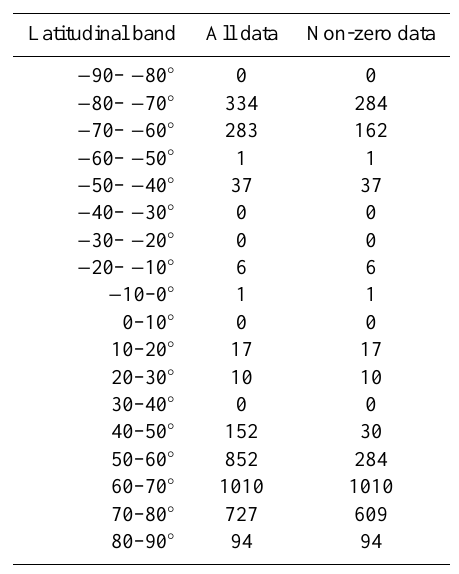
Table 3. Latitudinal distribution of abundance data in ten degree latitudinal bands ( − 90 to 90 ◦ ). Number of data points for each lat- itudinal band. All: all measurements, non-zero: data with non-zero carbon